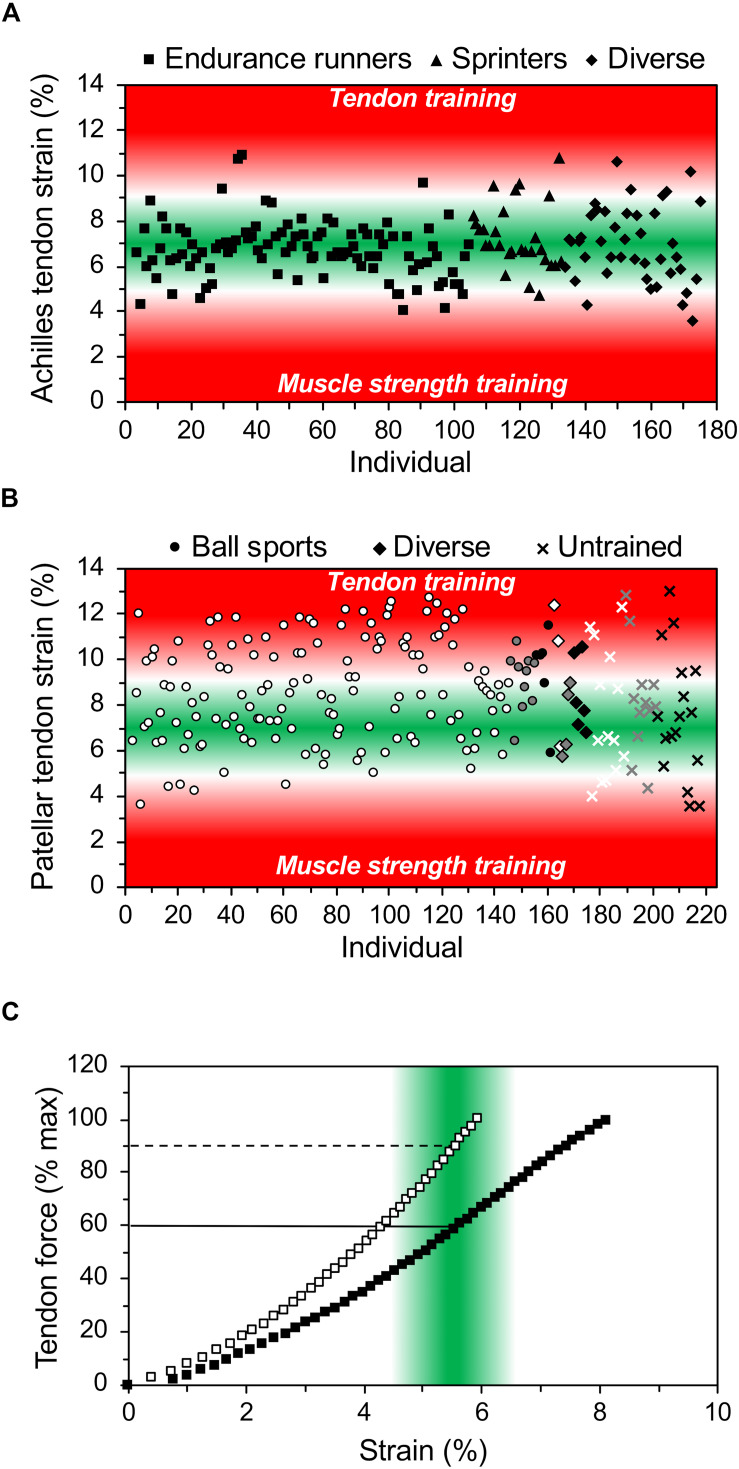
In vivo Achilles (A) and patellar (B) tendon strain during maximum voluntary isometric contractions in 172 and 215 athletes from different sports (endurance running, sprinting, ball sports, diverse) and untrained individuals from child- to adulthood (white: early adolescent [12–15 years], gray: late-adolescent [16–19 years], black: adults [≥20 years]). While low levels of tendon strain suggest that the athlete may focus on muscle strength development, high levels of strain indicate the need for specific tendon training for increasing its stiffness. (C) Illustrates the individual relationship of tendon force (in percent of maximum tendon force) and strain in two athletes. The green area indicates the range of strain where an optimal mechanical stimulation for training is expected and the horizontal lines show that the respective relative training intensity in terms of force exertion may differ substantially between individuals. The presented data is from earlier studies of our group (A: Arampatzis et al., 2007a, b, 2010; Stafilidis and Arampatzis, 2007; Albracht and Arampatzis, 2013; B: Charcharis et al., 2019; Mersmann et al., 2019) as well as yet unpublished work (A: n = 26; B: n = 118). Strain was extrapolated based on stiffness for the tendon forces during maximum voluntary isometric contractions in the respective optimum joint angle. For details on the respective methods see Arampatzis et al. (2007a) and Mersmann et al. (2016).